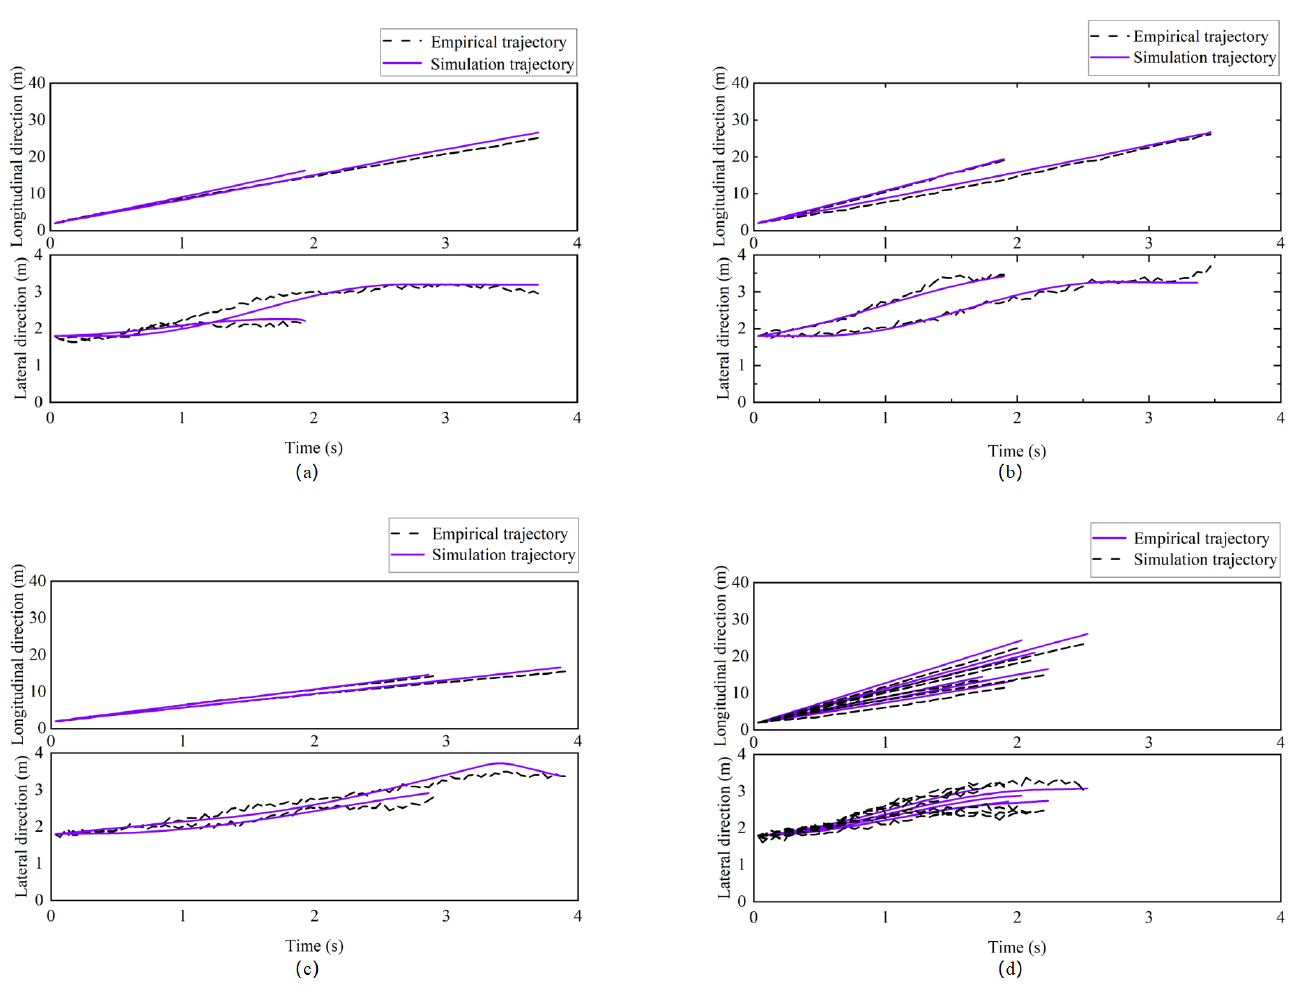
Figure 10. The rider’s decision-making process for overtaking. ( a ) Bicycle super bike. ( b ) Electric car super electric car. ( c ) Bicycle ultra electric vehicle. ( d ) Electric vehicle super